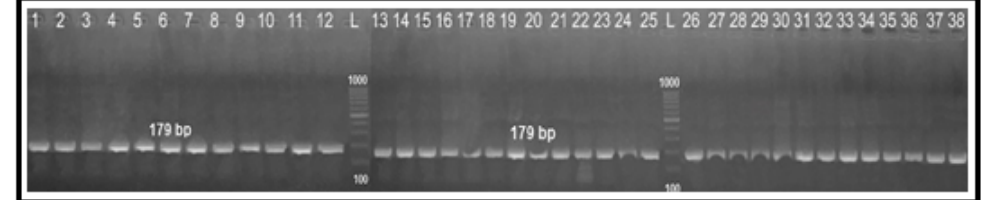
Figure 7. PCR-restriction fragment length polymorphism patterns obtained after digestion of gyrA PCR products with FastDigest Rsa I enzyme. Lane L: 100 bp DNA ladder and lanes 1–38: PCR-RFLP fragments obtained for Campylobacter species isolated from human and chicken samples.